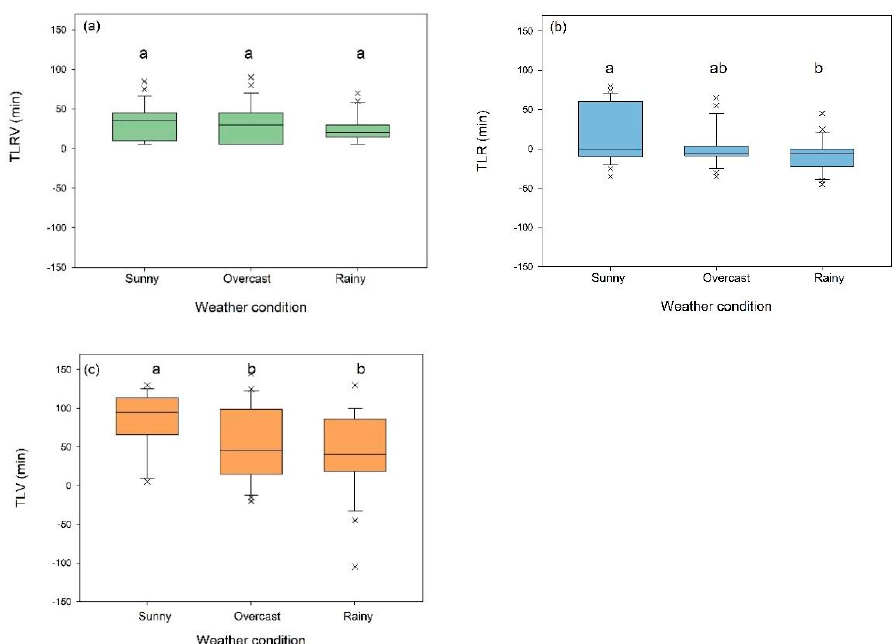
Figure 3. The distributions of time lag for different weather conditions: ( a ) Time lag between vapor pressure deficit and solar radiation (TLRV); ( b ) time lag between sap flux density and solar radiation (TLR); ( c ) time lag between sap flux density and vapor pressure deficit (TLV). In the boxplots, the line drawn within the box represents the median; the box extends to the upper and lower quartiles. The different letter above the box indicate the significant difference between the two boxes, and the same letter above the box indicate the insignificant difference ( p < 0.05). Positive time lag values represent J s (sap flux density) peaks preceding peaks in meteorological drivers, while negative time lag values represent J s peaks lagging behind peaks in meteorological drivers.